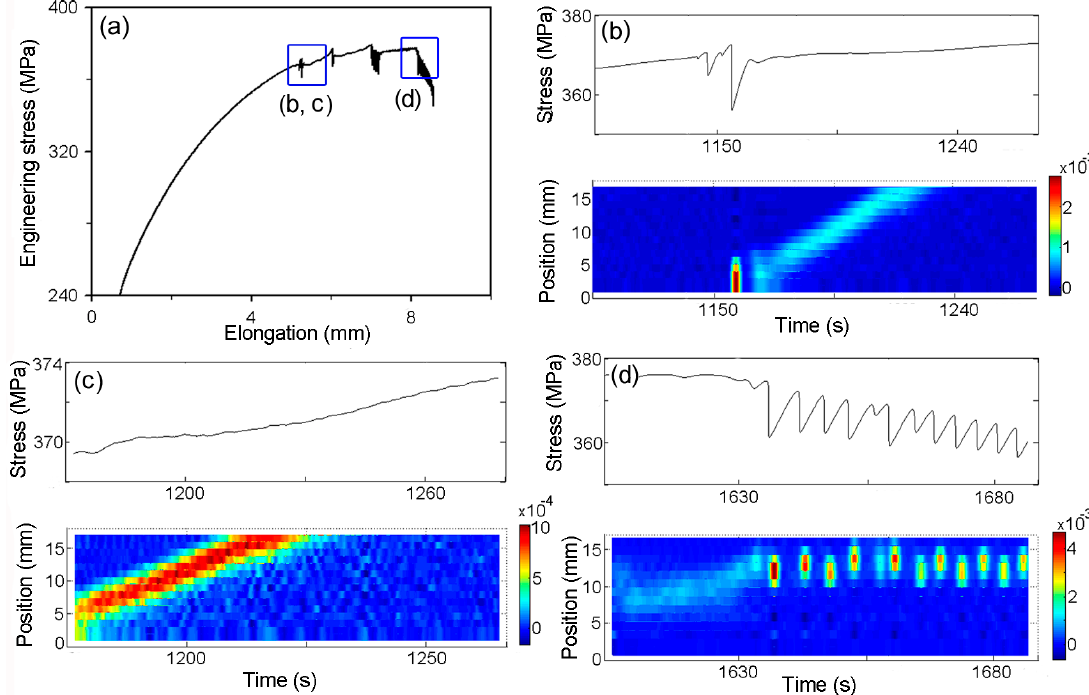
Figure 5. ( a ) Deformation curve recorded at 1.4 × 10 − 4 s − 1 in the CG state and the corresponding strain-rate maps for the strain intervals denoted by rectangles: ( b ) Time interval covering the nucleation of a band and its following propagation; ( c ) Portion of plot ( b ) corresponding to the band propagation; ( d ) Oscillating deformation curve observed during necking and the repetitive strain localization responsible for these serrations.